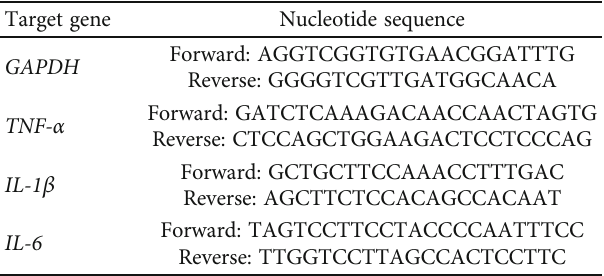
Table 1: Primers used for